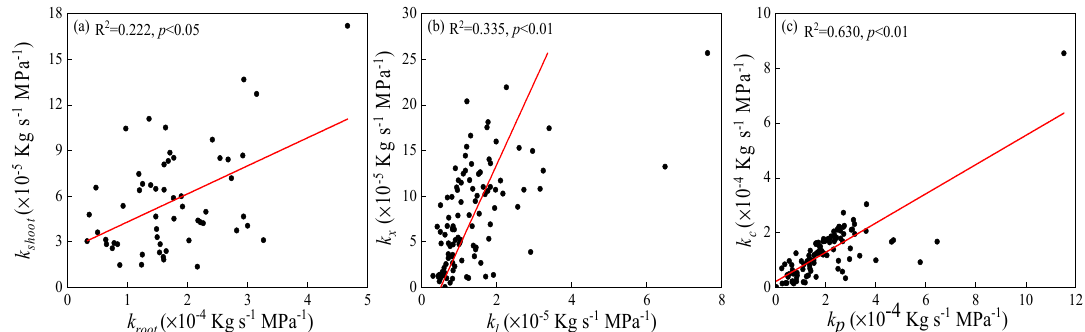
Figure 5. Regression analysis of hydraulic conductance of specific plant parts. ( a ) whole-roots ( k root ) and whole-shoots ( k shoot ); ( b ) leaf blades ( k l ) and one-year shoots ( k x ); and ( c ) petioles ( k p ) and current-year shoots ( k c ). All regressions shown were highly significant ( p < 0.05).